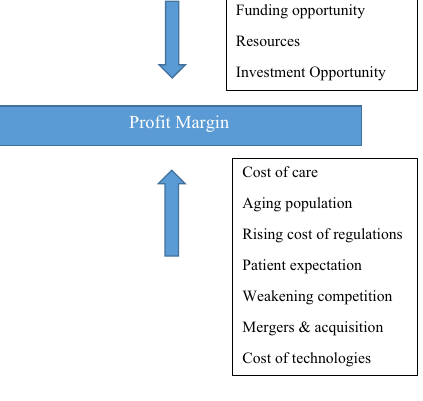
Figure 1. Health-care